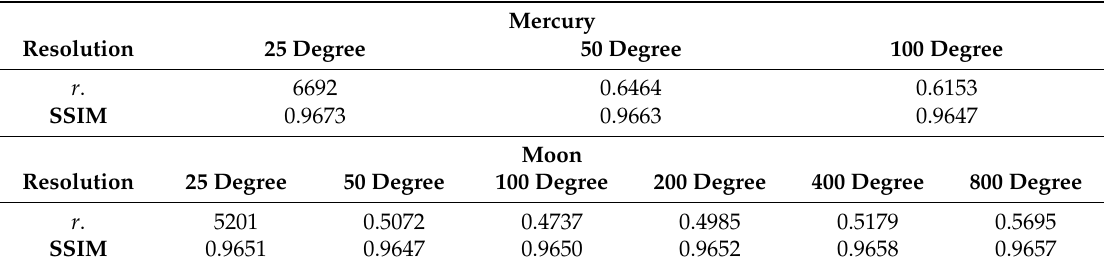
Table 1. The similarity between gravity field data and DEM